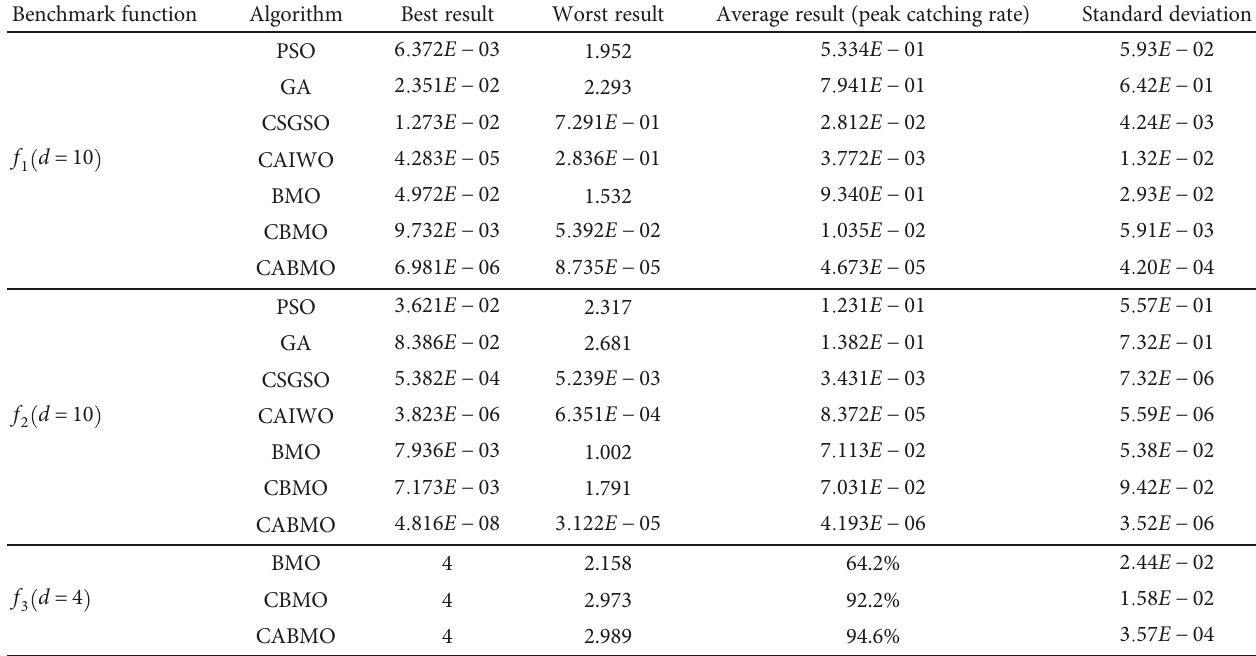
Table 1: The results of benchmark